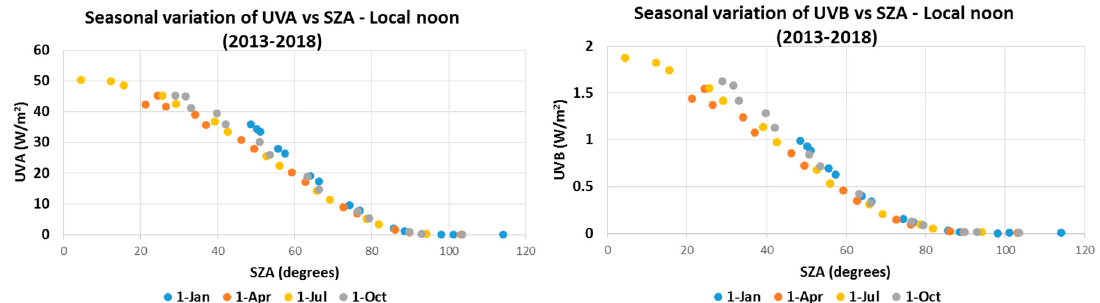
Figure 7. Diurnal variation of UVA and UVB radiation with solar zenith angle in Doha, Qatar on four dates (1 January, 1 April, 1 July, and 1 October) showing the seasonal variation.